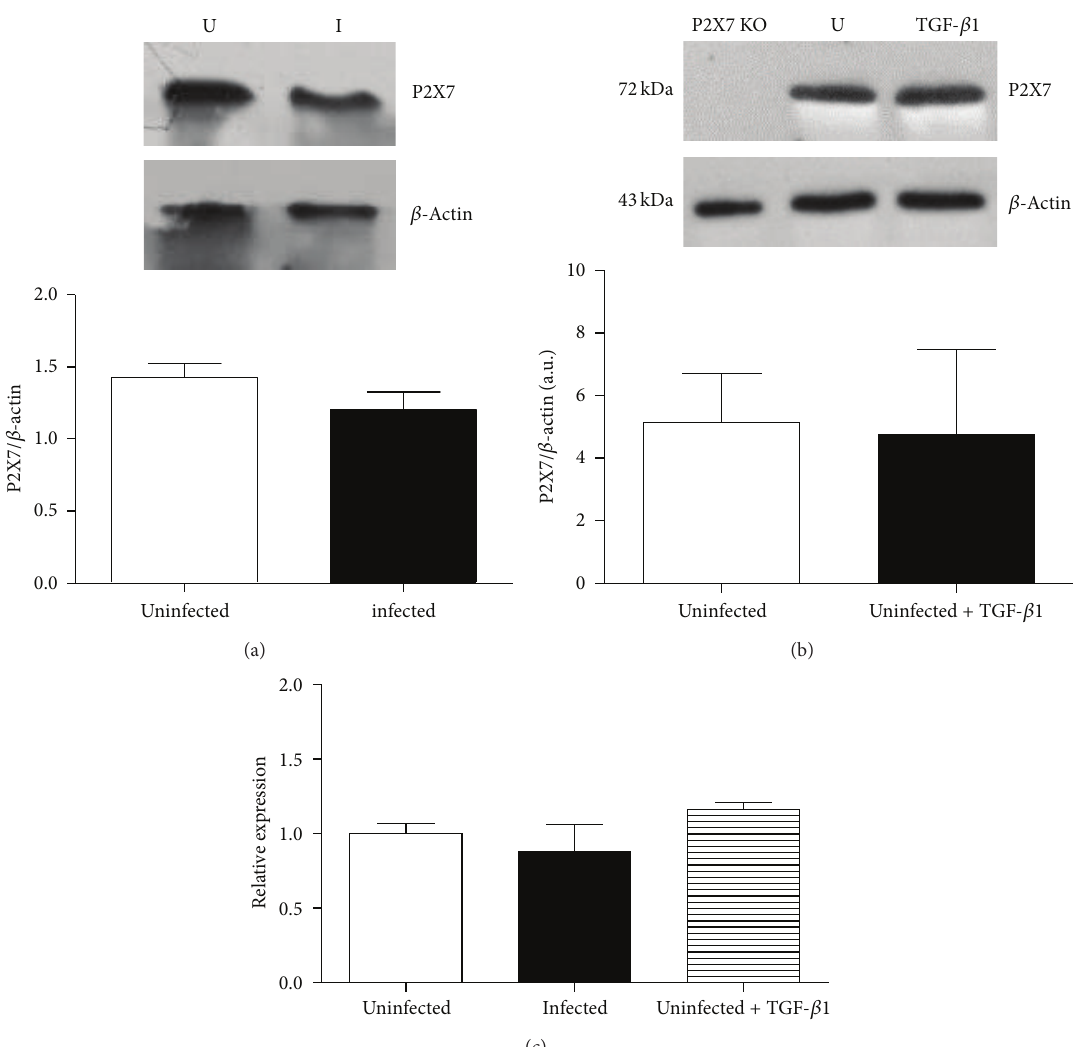
Figure 5: P2X7 receptors expression in peritoneal macrophages. (a) Macrophages from uninfected (white bar) and S. mansoni -infected (black bar) mice express similar levels of P2X7 protein. 𝑛 = 9 replicates from three different animals, for each group. The images above are representative Western blots (U = uninfected and I = infected). (b) P2X7 receptors expression in peritoneal macrophages from control mice (white bar, untreated) or TGF- 𝛽 1-treated cells (5ng/mL, 24 h; black bar) are also similar. The images above are representative Western blots (U = uninfected; TGF- 𝛽 1= TGF- 𝛽 1-treated macrophages). Lysates from P2X7 KO macrophages were used as negative controls for P2X7 protein expression. Cells lysates were obtained from three animals for each group. (c) Quantitative RT-PCR (qRT-PCR) analysis of P2X7 receptor mRNA levels in peritoneal macrophages. Similar levels of P2X7 mRNA were found in uninfected (white bar), S. mansoni -infected mice (black bar), and TGF- 𝛽 1-treated (5ng/mL, 24 h; hatched bar) mouse macrophages. 𝑁 = 3 – 5 samples per group (using different